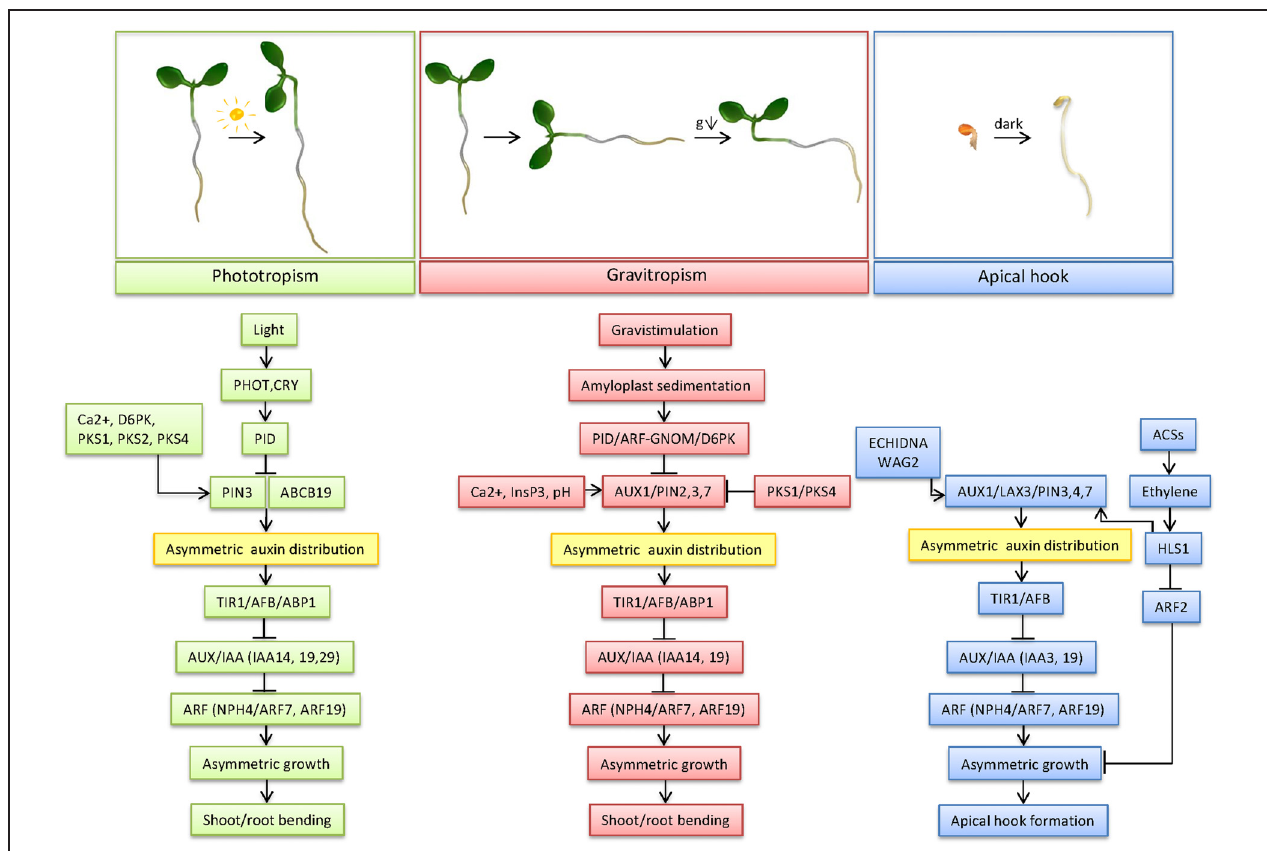
FIGURE 1 | Mechanism of differential growth in phototropism, gravitropism and apical hook development. This model depicts the most important factors in the regulation of the three forms of differential growth, from trigger sensing to bending of the concerned organs, centered around auxin transport and signaling as key mechanisms underlying differential